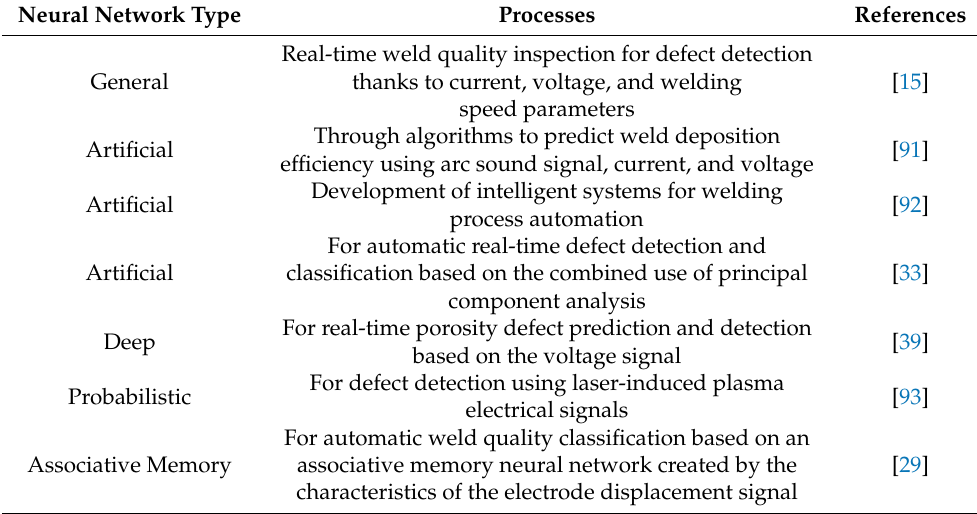
Table 1. Various uses for improved modeling through neural networks.